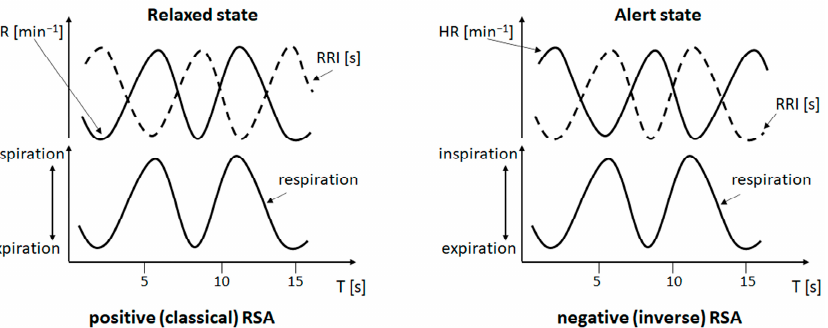
Figure 1. Cardio-respiratory phase-relations: upper curves show heart rate (HR, solid line) and cardiac beat-to-beat interval (RRI, dotted line), lower curves show respiration. Slow cardiac and respiratory waves are presented in both panels for reasons of comparability. The left panel depicts positive (classical) RSA with inspiration coinciding with increasing HR (decreasing RRI) and expiration coinciding with decreasing HR (increasing RRI). This phase-relation typically occurs in a resting and relaxed state. The right panel depicts negative (inverse) RSA with inspiration coinciding with decreasing HR (increasing RRI) and expiration coinciding with increasing HR (decreasing RRI). This phase-relation occurs rarely. In awake subjects, it has predominantly been observed in situations of elevated anxiety and during slow